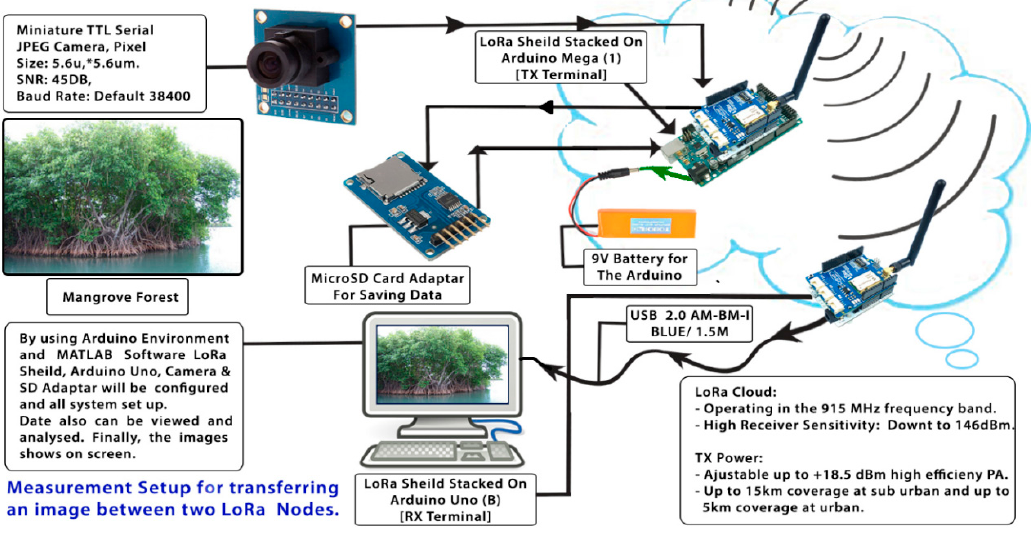
Figure 9. Experimental setup for transferring images of the mangrove forest between two LoRa nodes.